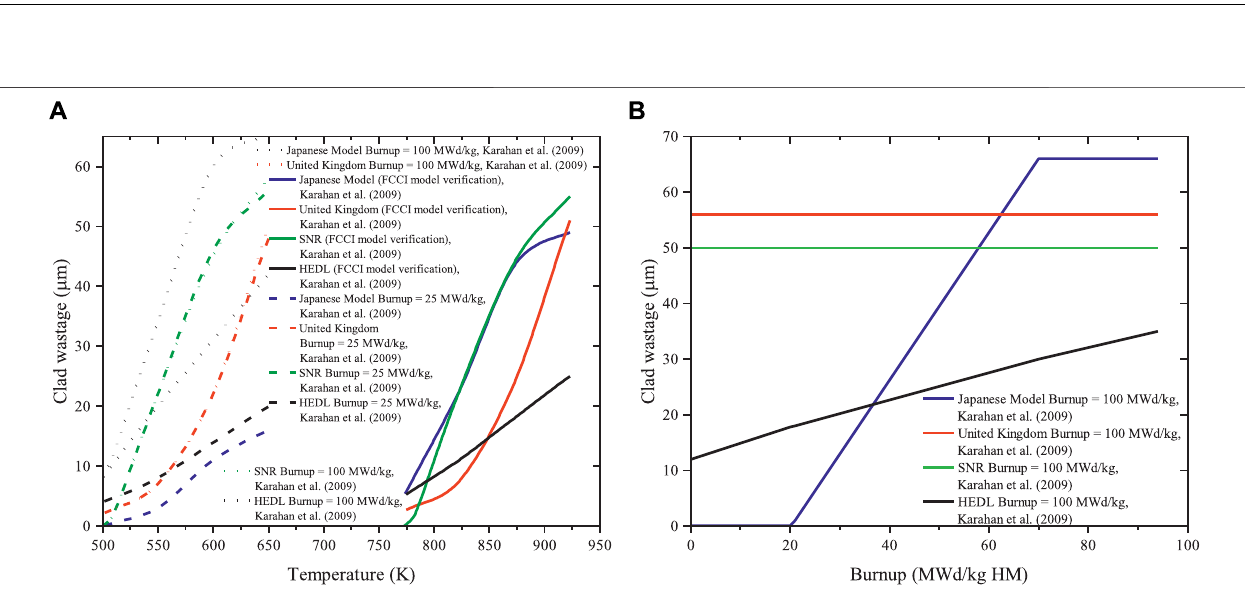
FIGURE 7 | Clad wastage with (A) temperature and (B) burnup in the metallic fuel (Karahan et al., 2009).